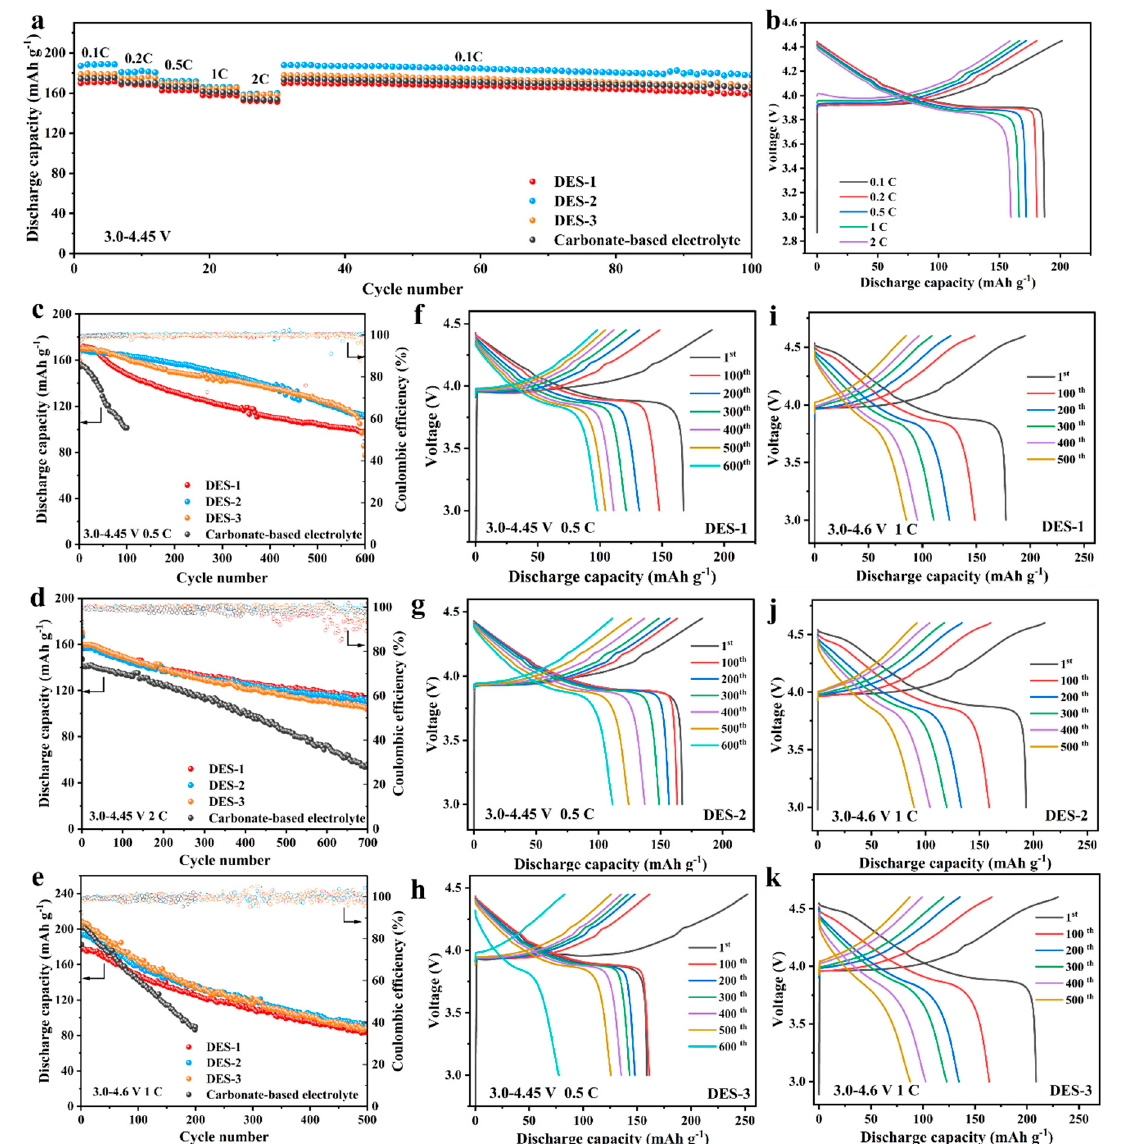
Figure 5. ( a ) The rate performance of three DES electrolytes and carbonate-based electrolytes at 25 °C. ( b ) The charge–discharge curves of DES-2 with different current densities. The cycling perfor- mance of LCO||Li cells with different electrolytes at 25 °C and ( c ) 0.5 C and ( d ) 2 C and under